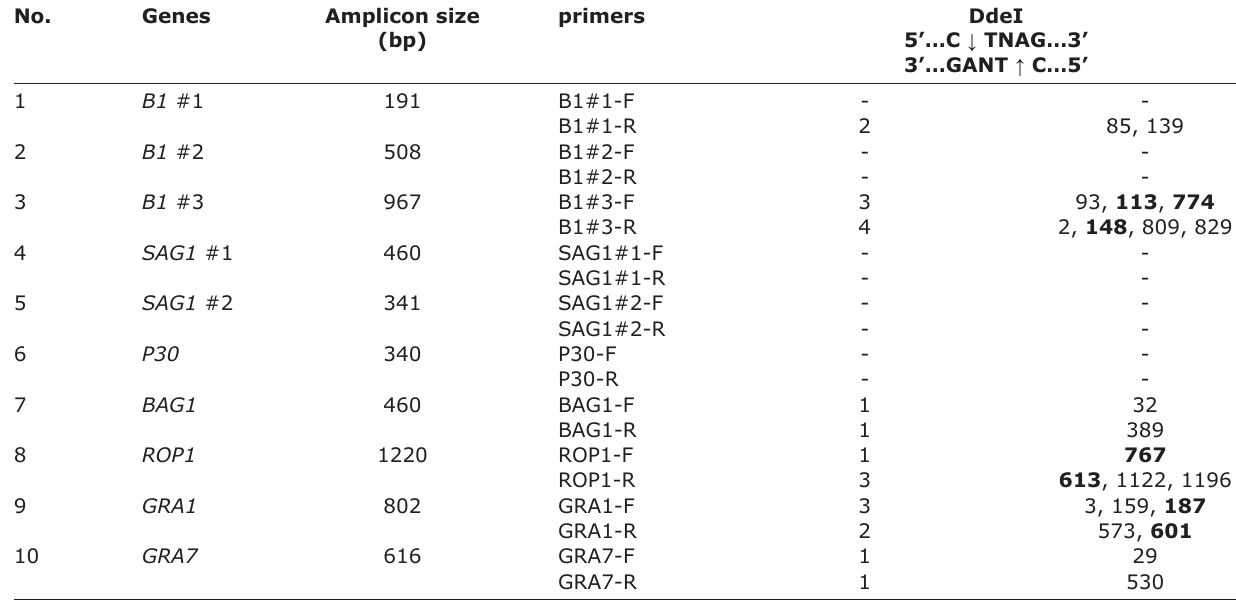
Table-2: In silico restriction site analysis of genes sequences digested using enzyme DdeI. No.